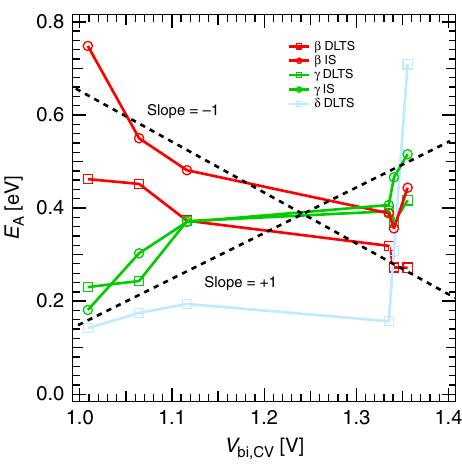
Fig. 4 Activation energy versus built-in potential. Activation energy E A of the ionic defects β (red), γ (green), and δ (blue) plotted in dependence of the built-in potential V bi,CV extracted from CV measurements for all investigated perovskite solar cells. The dashed lines with slopes of ±1 are guides for the